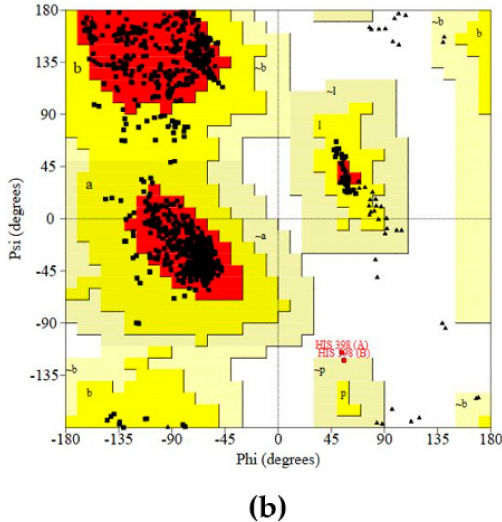
Figure 3. Ramachandran plot validating the prepared protein structure of cyclooxygenase (COX-2) from ( a ) mouse (PDB ID 3NT1) ( b ) human (PDB ID: 5F19).